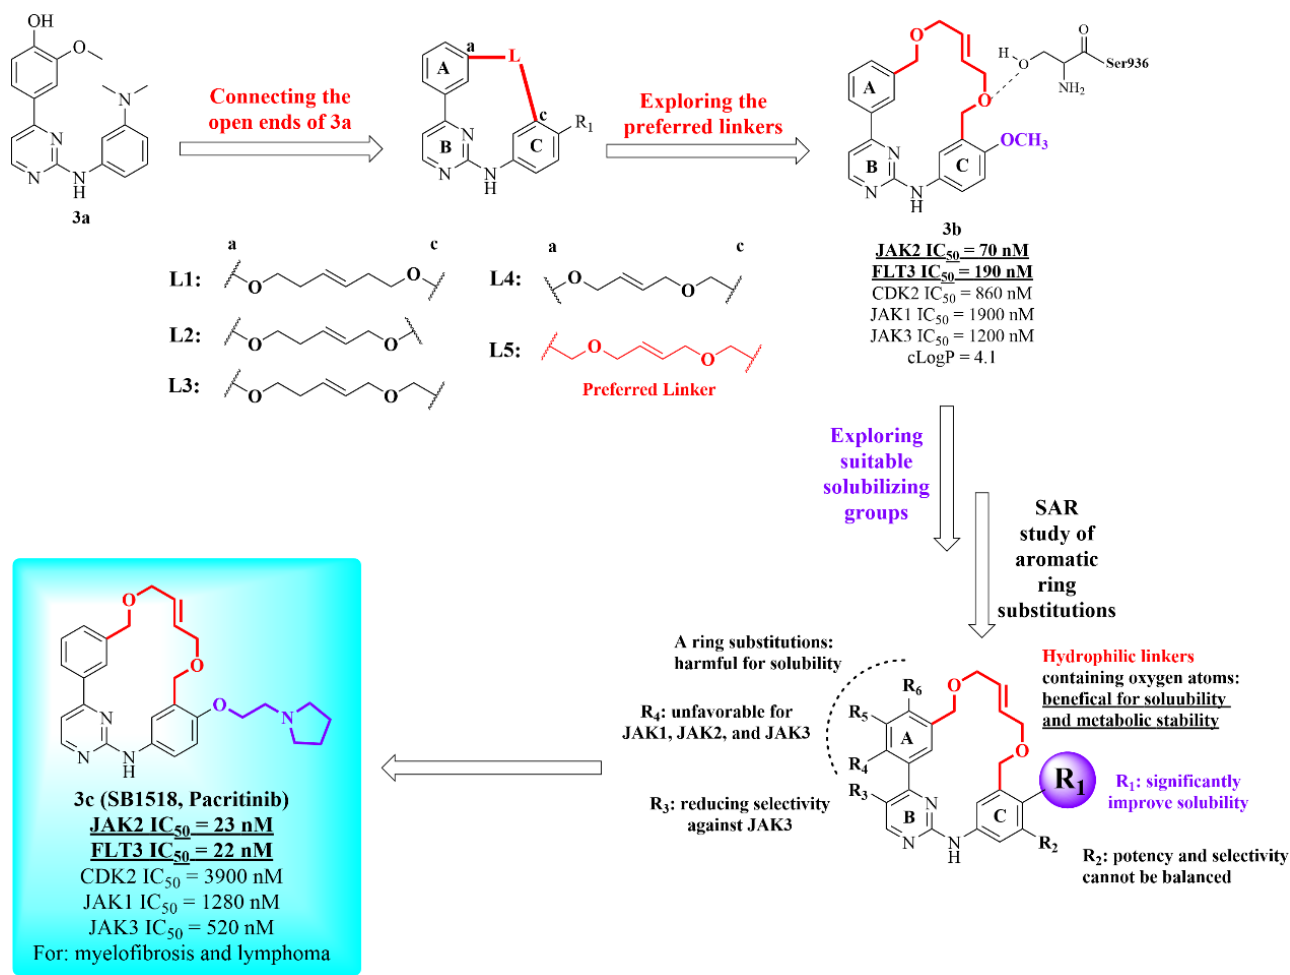
Figure 4. Structural modification of compound 3c .